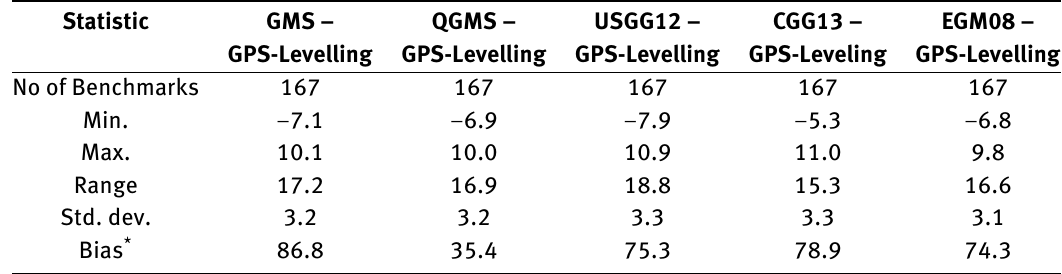
Table 10: Statistics of the differences between the different geoids and GPS-levelling benchmarks for the New Hampshire test area. Unit is in